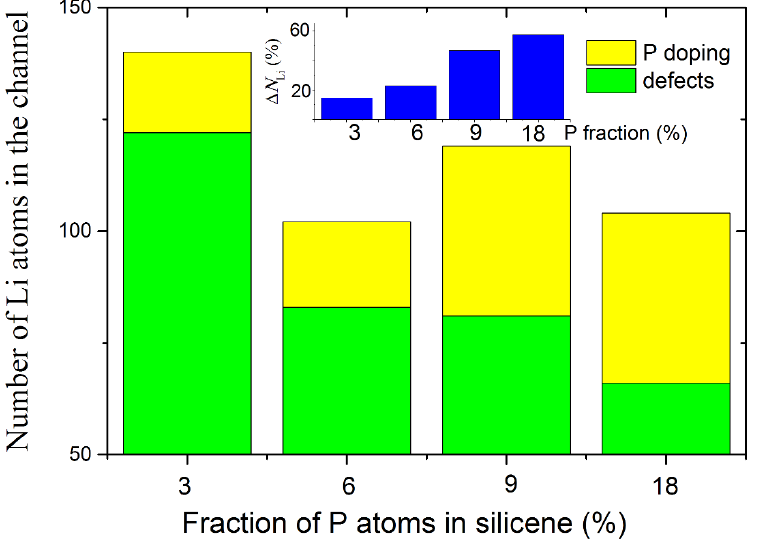
Figure 11. Total number of Li atoms successfully incorporated into the silicene channel in the case of the doped systems; an inset illustrates a change in channel capacitance after doping; the channel is located on a nickel substrate doped with 5% Cu. Adopted with permission from Ref. [39]. 2021, Elsevier.